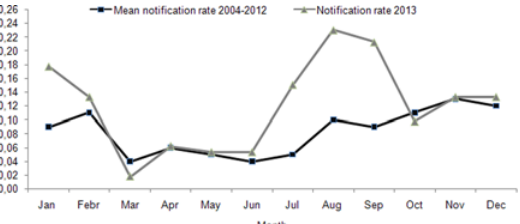
Figure 3. Mean monthly notification rate of hepatitis A for 2004 – 2012 and monthly notification rate in 2013, Mandatory Notification System,